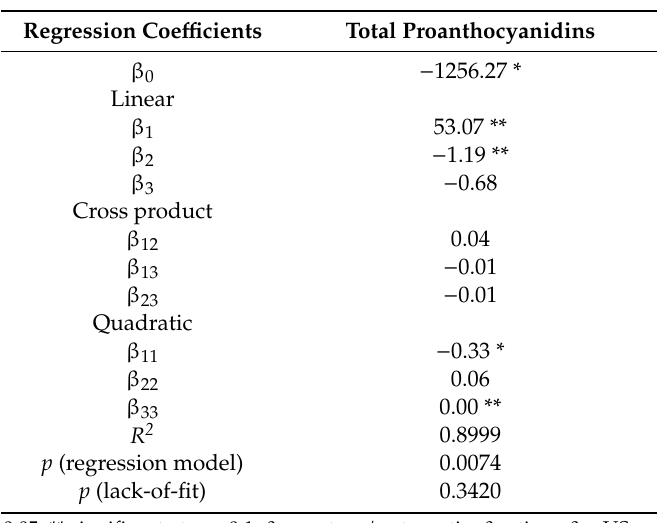
Table 4. Regression coe ffi cients and ANOVA